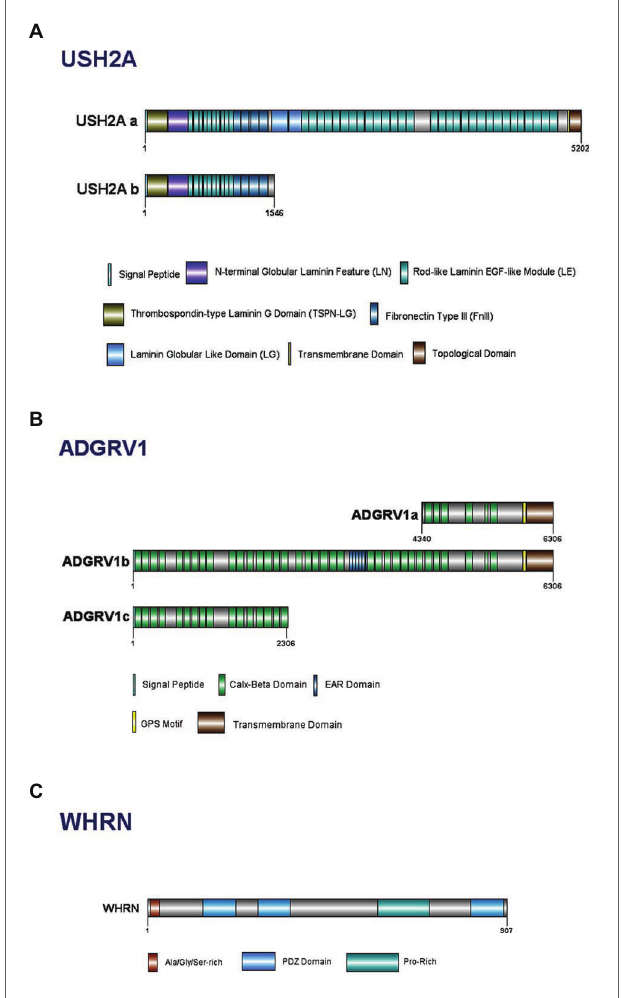
FIGURE 3 | Domain structure of Usher Type II proteins and their major isoforms: (A) usherin; (B) ADGRV1; and (C)